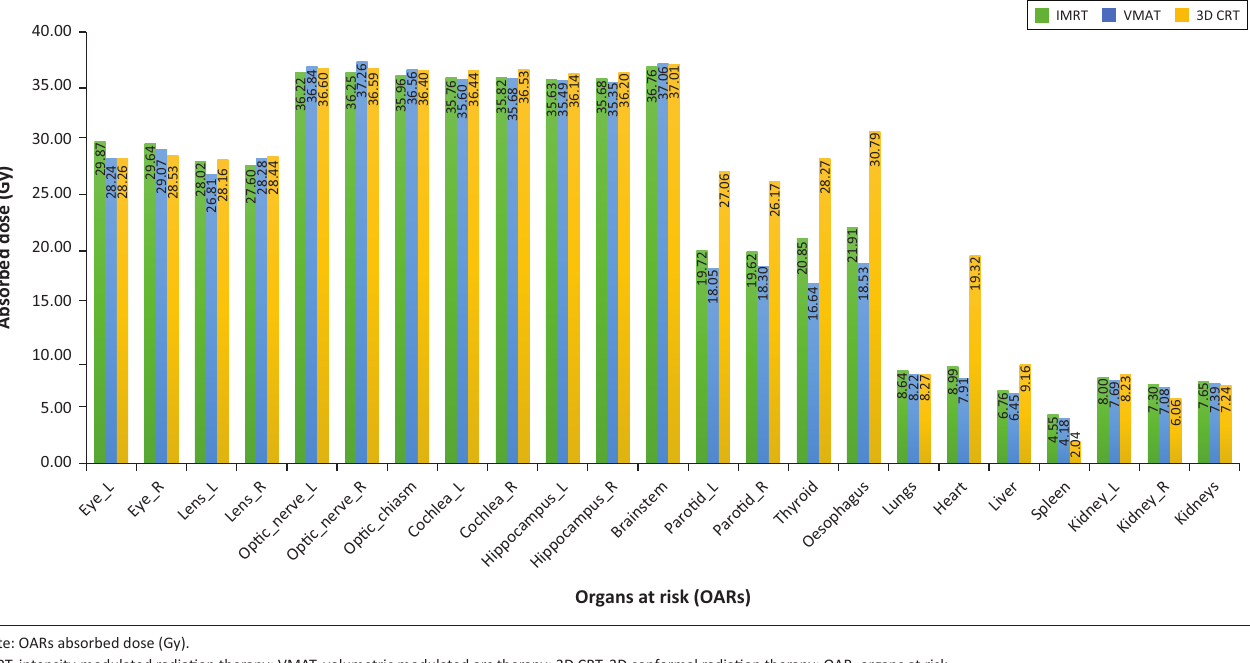
FIGURE 3: Organs-at-risk dose exposure for intensity-modulated radiation therapy, volumetric modulated arc therapy and 3D conformal radiation